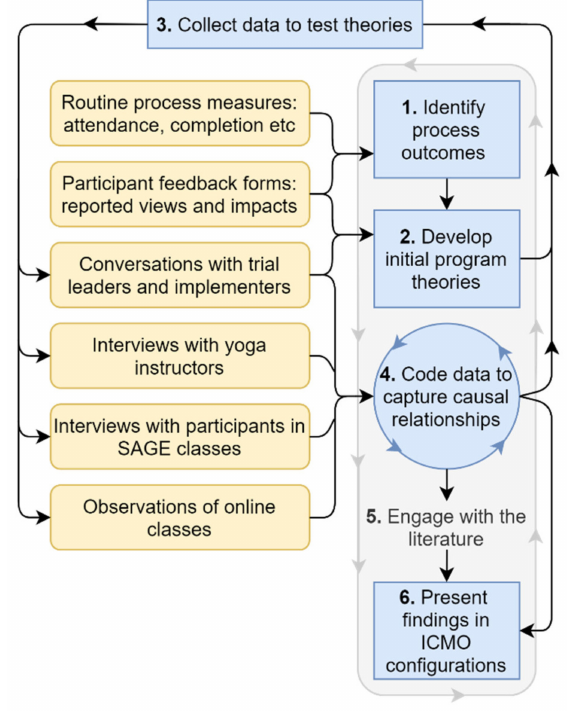
Figure 1. An overview of our realist process evaluation